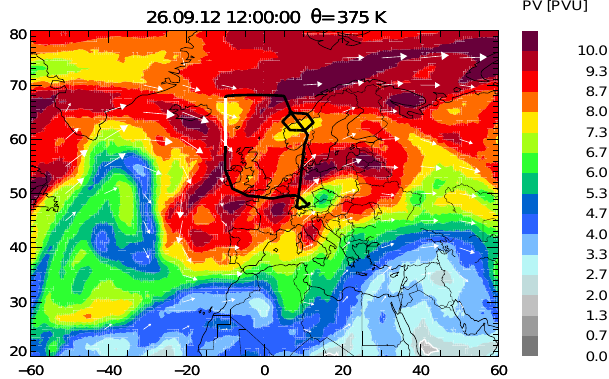
Fig. 1. The horizontal distribution of PV at 375K potential temperature over Northern Europe on 26 September 2012. The flight path for the TACTS flight on 26 September 2012 (at flight time) starting and ending in Oberpfaffenhofen (near Munich, 48 ◦ N 11 ◦ E, Germany) is marked in black. The part of the flight path discussed within this paper is highlighted in white (cf. Sect. 2 and see Fig. 2). The horizontal winds are indicated by white arrows. PV and horizontal winds are from ERA-Interim reanalysis data.